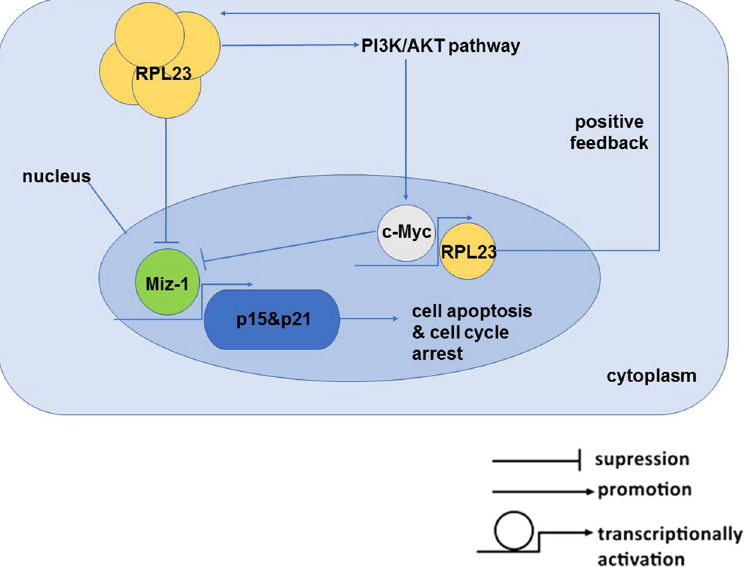
Figure 6. Schematic showing the potential role of RPL23 in the RPL23/Miz-1/c-Myc circuit. Our study suggests a regulatory feedback loop through which RPL23 reinforces the Myc-dependent oncogenic functions. Elevated expression of RPL23 would decrease the Miz-1-dependent expression of p21 Cip1 and p15 Ink4b , thereby increasing the ability of c-Myc to promote cell cycle progression. In turn, the activation of c-Myc function in the context of RPL23 overexpression might further stimulate RPL23 expression, representing a positive feedback mechanism that couples efficient RPL23 expression with c-Myc’s function to suppress Miz-1-induced Cdk inhibitors and thereby promote cell cycle progression and induce apoptotic